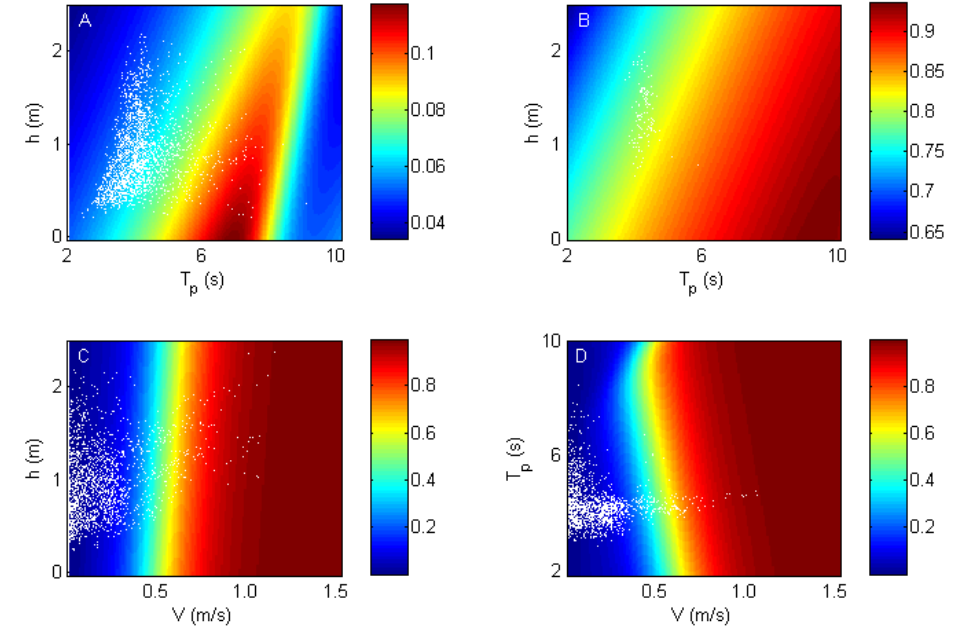
Fig. 7. Sensitivity of the best-performing ANN (Fig. 6c. Input variables are V , h and T p ) to changes in the input variables. Colour-bar represents depth-integrated suspended sediment transport (kg/m/s). Notice the top subplots have a different colour-scale. In (A) and (B) , V is equal to 0.17 (the mean value in the observations) and 0.7m/s, respectively. In (C) T p is equal to 4.3s (mean value) and in (D) h is 0.94m (mean value). White dots represent observations whose value of the fixed variable is within ± 1 standard deviation from the fixed